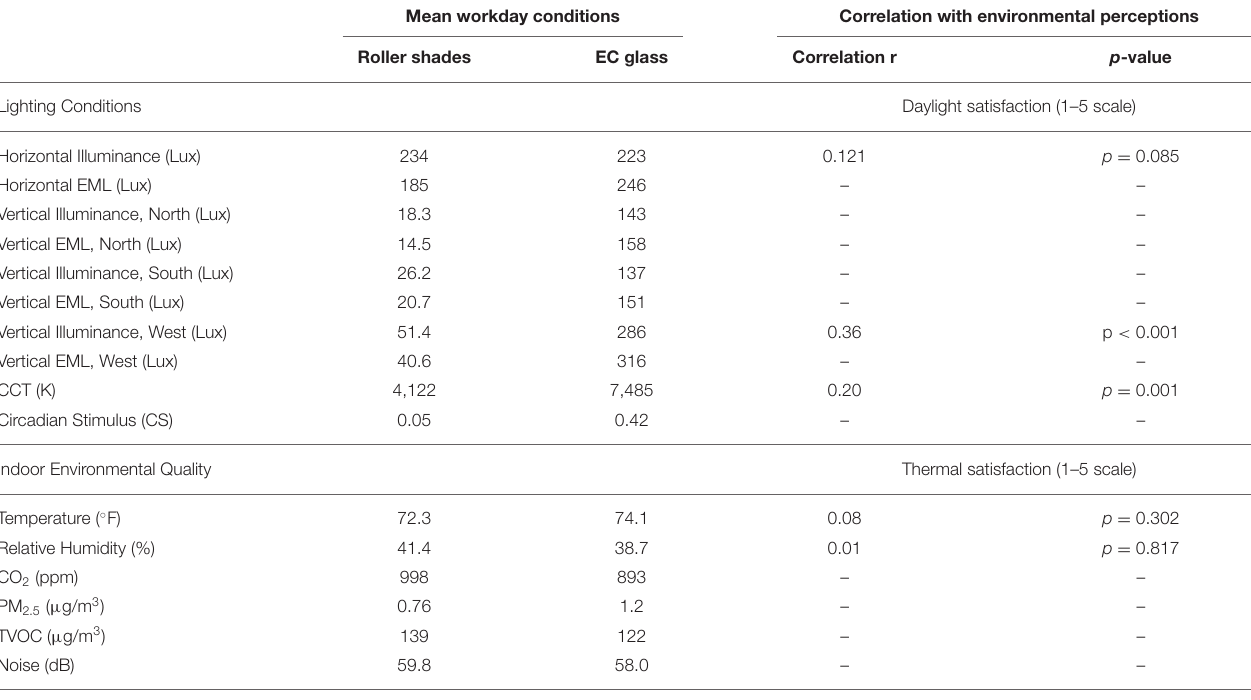
TABLE 2 | Environmental conditions in the two office environments (Mean workday conditions), with values represent average conditions over the course of the study period during work hours (9 am − 5 pm). Mean workday conditions Correlation with environmental perceptions Roller shades EC glass Correlation r